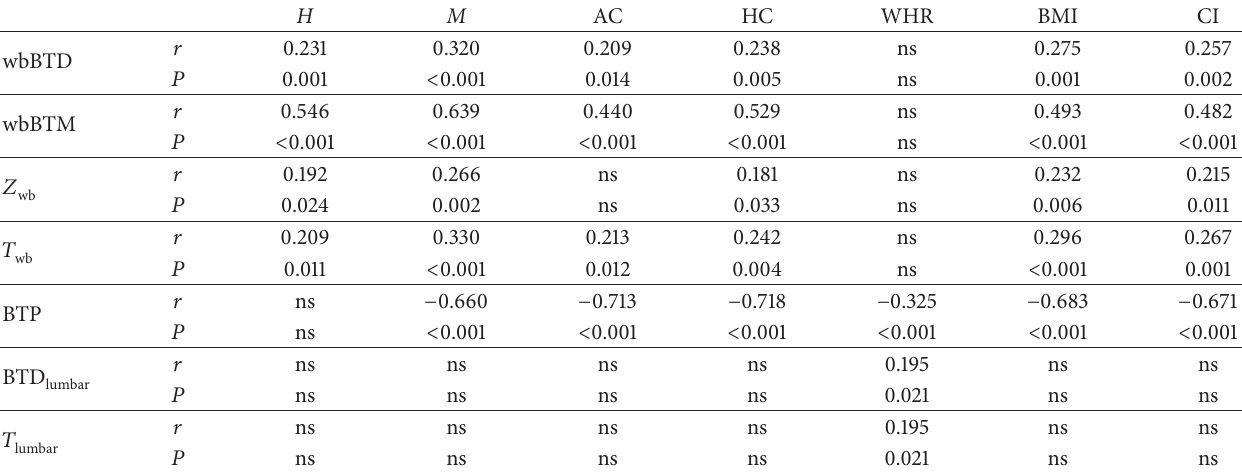
Table 4: Correlation of wbDXA bone indices and anthropometric indices ( 𝑛 = 141